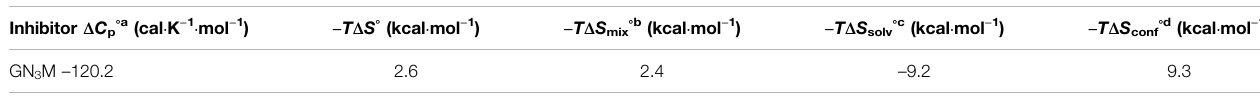
TABLE 1 | Parameterization of the entropic term for binding of GN 3 M to HEWL at 25 °